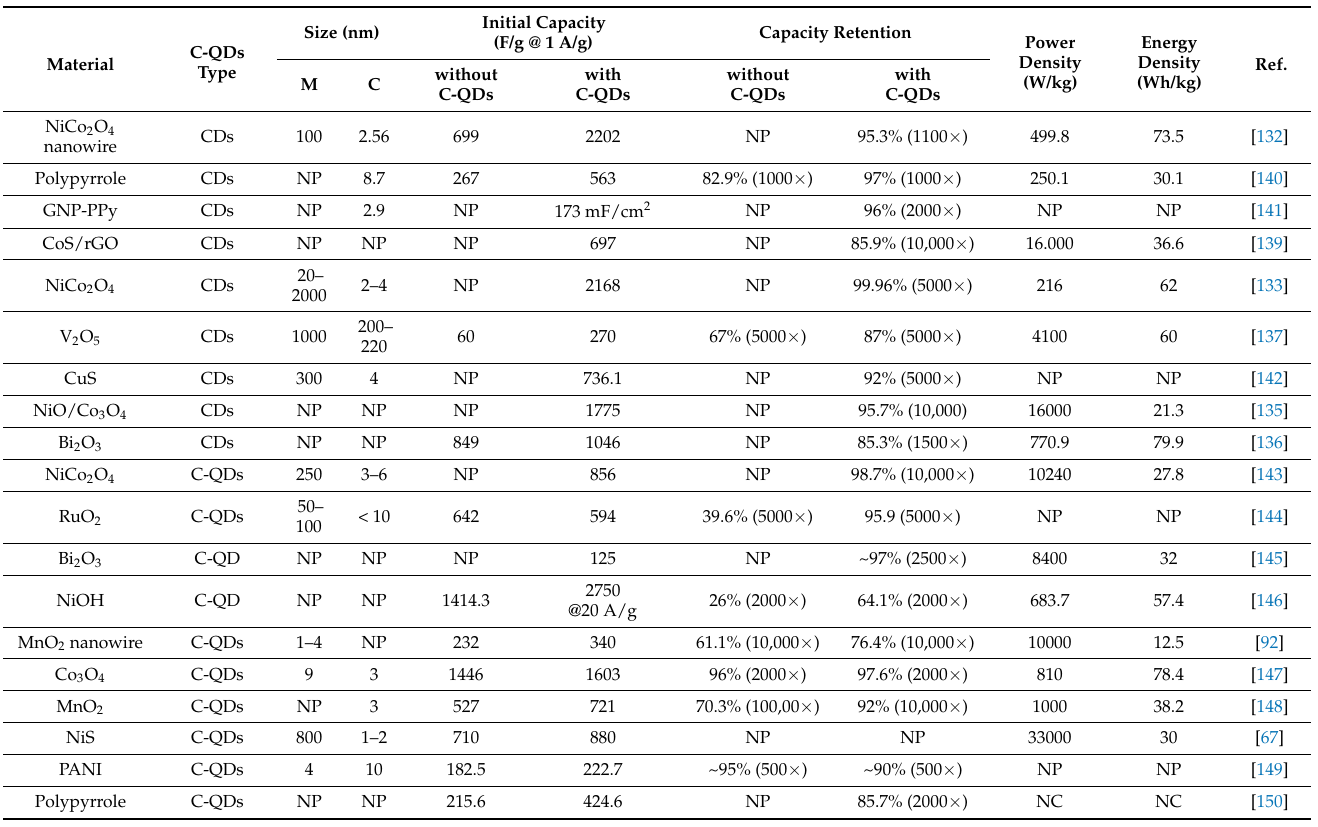
Table 2. Summary of various C-QD composites with their performance parameters for supercapacitor application (M = Transition Metal Composite, C = C-QDs, NP = Not